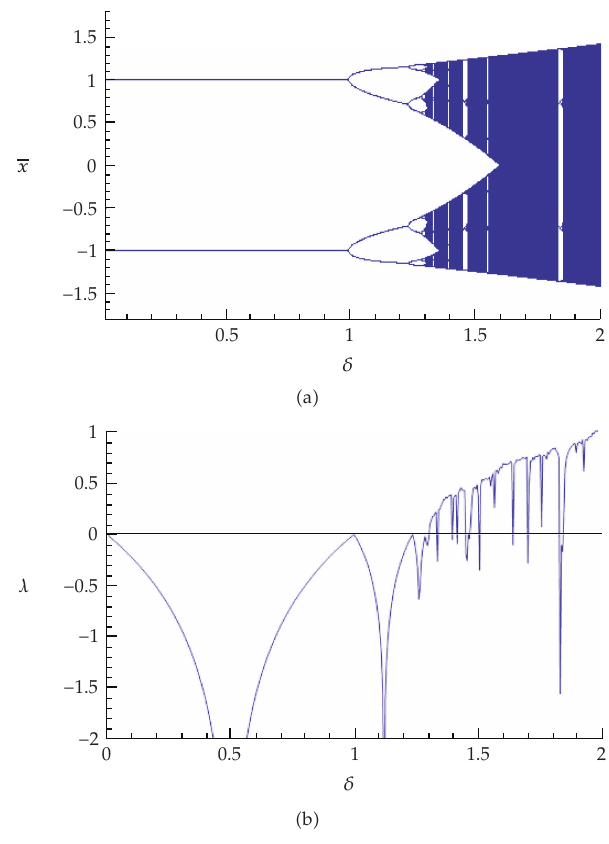
Figure 7: Bifurcation and Lyaponov exponent diagrams as a function of δ